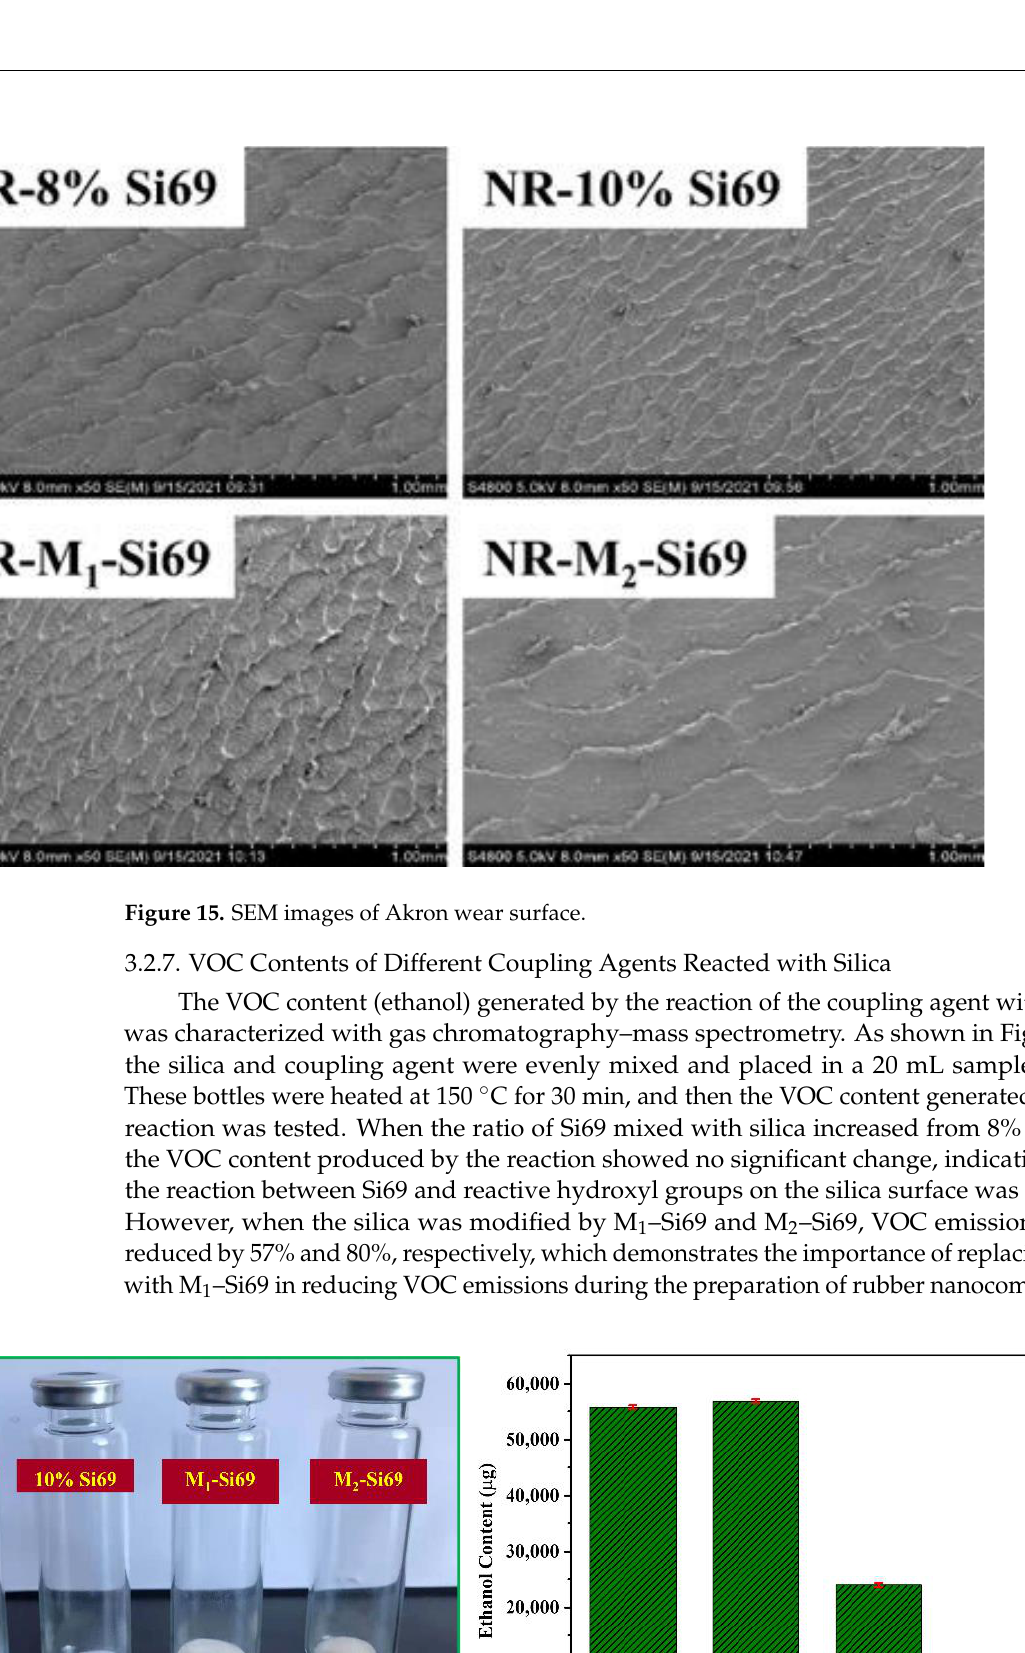
Figure 16. Characterization of the VOC content of coupling agent-modified silica. 4. Conclusions In conclusion, NRCs can beneficially weaken silica networks and improve the dis- persion of silica in rubber matrixes. In addition, the combination of silica and polyether